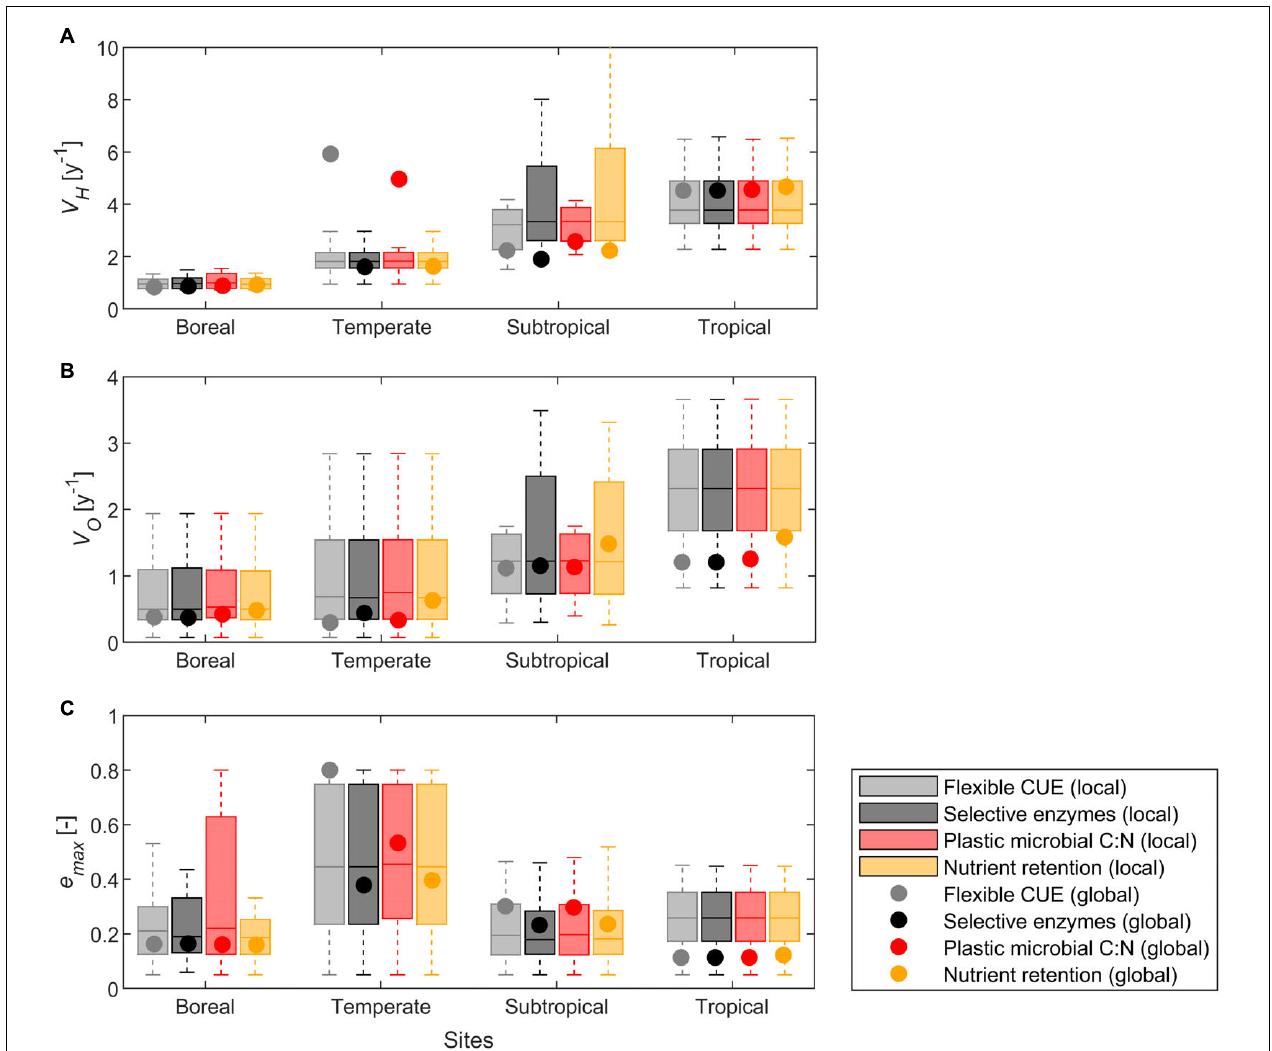
FIGURE 6 | Calibrated model parameters, including results from the local (box plots) and global (points) parameter optimization approaches: (A) maximum rate of hydrolysable C uptake ( V H ), (B) maximum rate of oxidizable C uptake ( V O ), and (C) maximum growth efficiency ( e max ). Datasets are grouped by climate ( Table 4 ) and resource use mode (color coded according to the legend). Each box indicates median and quartiles, and whiskers cover the data range excluding